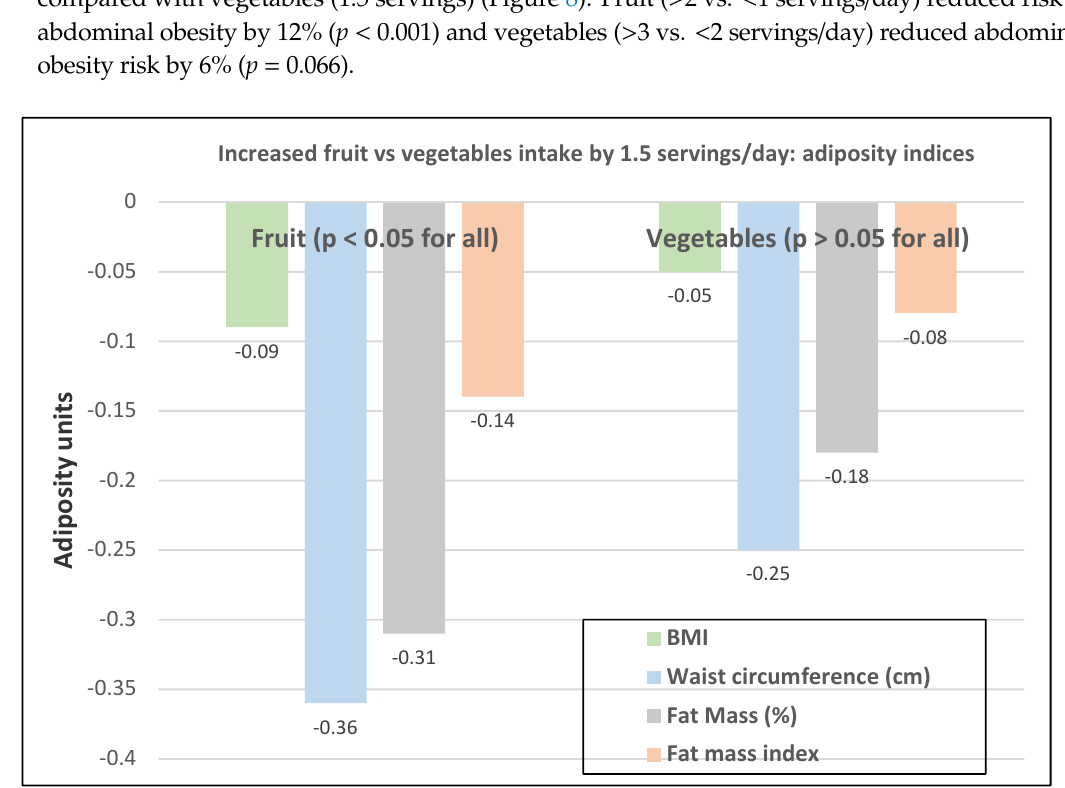
Figure 8. Multivariate adjusted associations between increased intake of fruit and vegetables by 1.5 servings/day and adiposity indices (26,340 participants, 70% women, mean age 53 years, and BMI 28.5) [36].